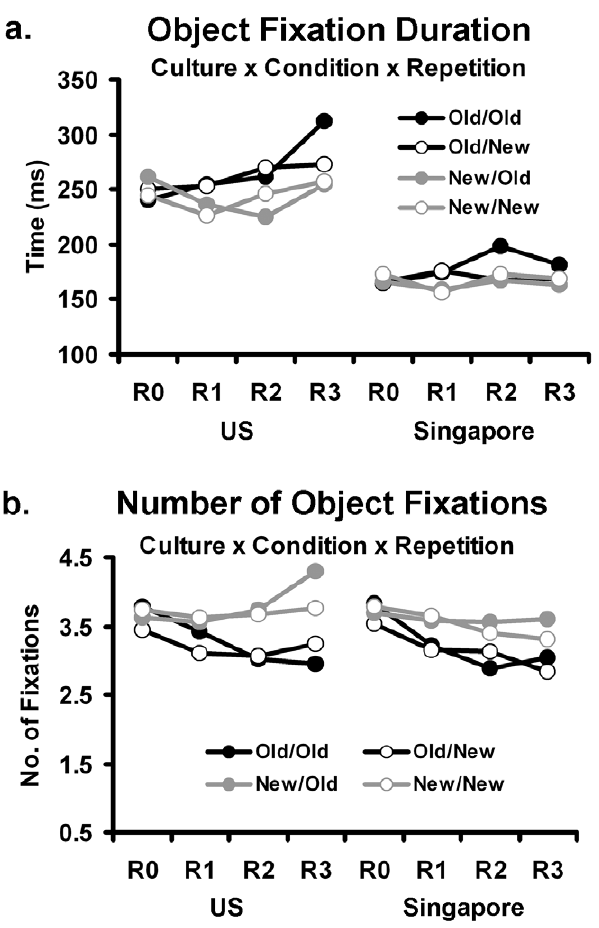
Figure 2. Mean object fixation data for US and Singapore participants. Mean object fixation durations (a) and number of object fixations (b) are shown across all quartet conditions (Old and New objects/backgrounds) and picture repetitions (R0 to